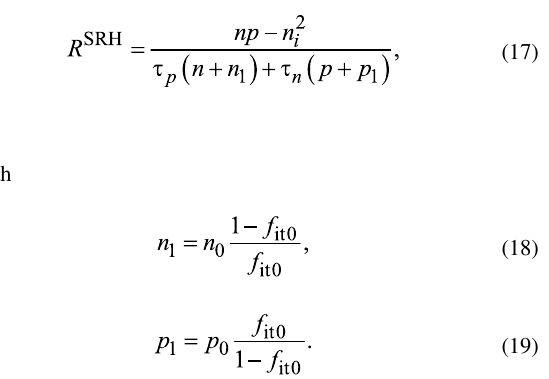
The net generation/recombination rate R SRH is given by